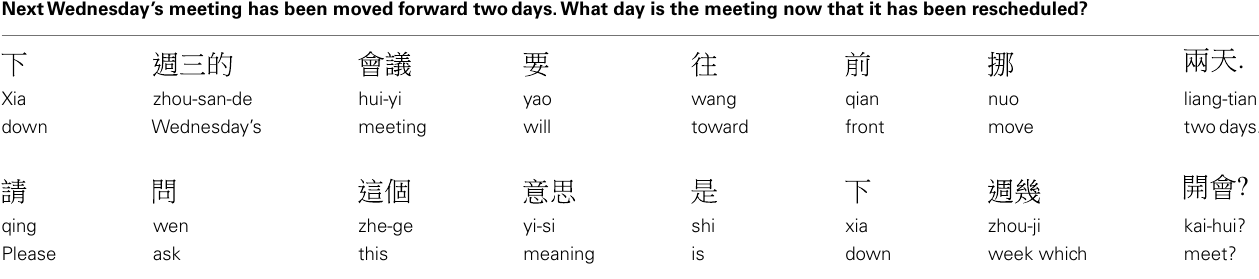
Table 2 |The meeting question in English (top) and Mandarin (bottom).